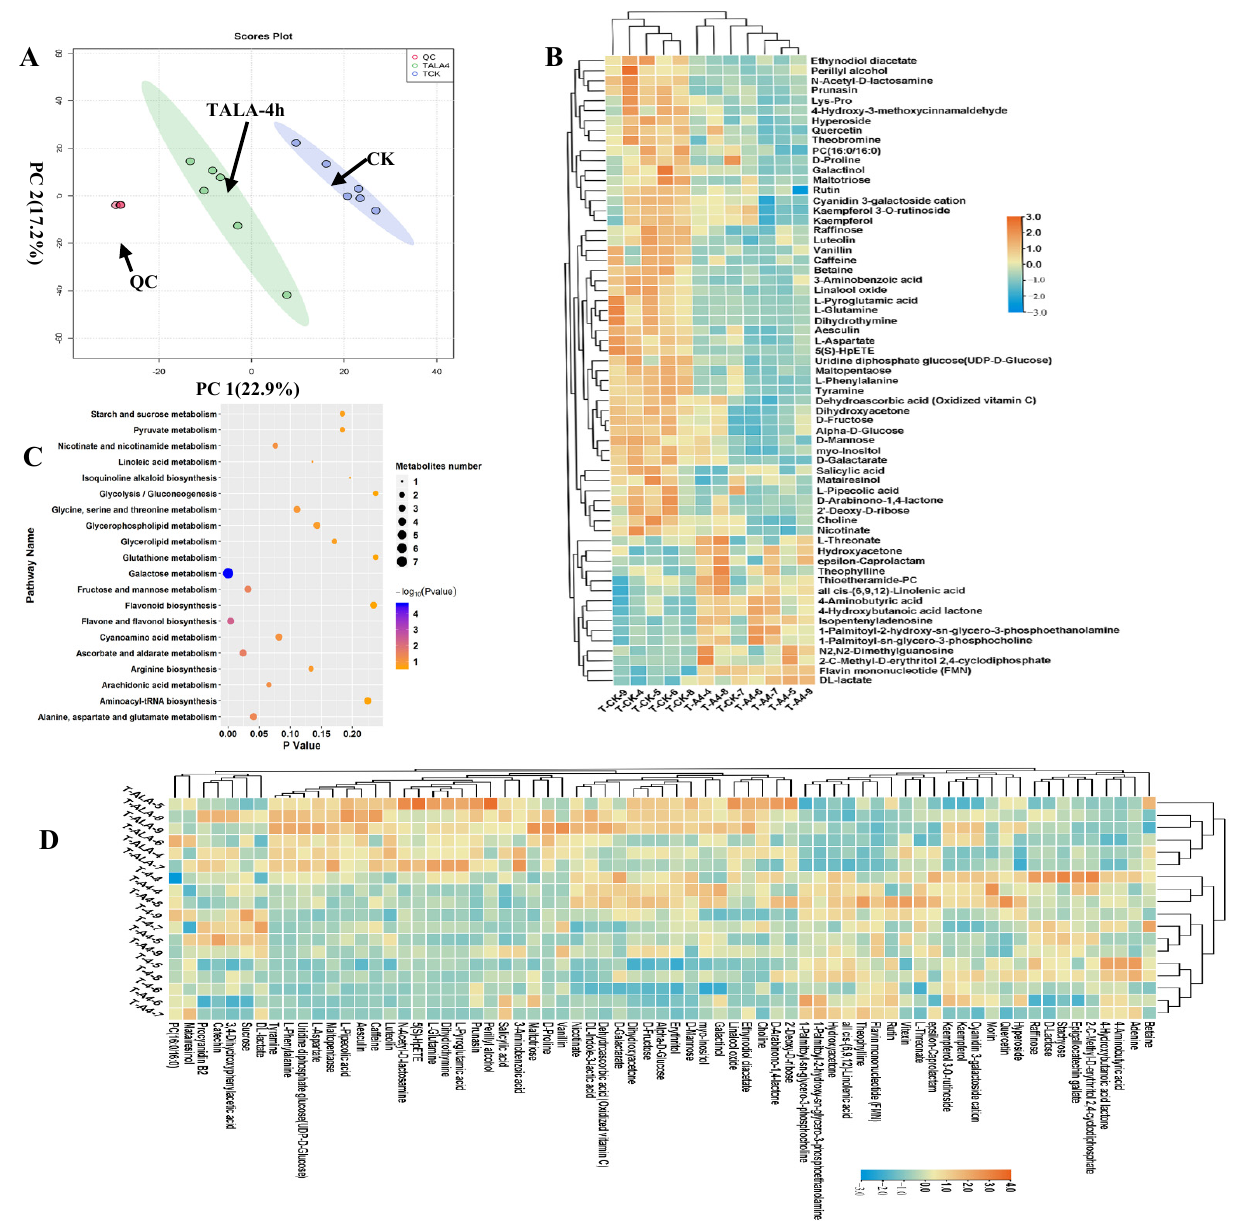
Figure 4. Metabolic alterations in ALA-treated tea tissue under cold stress. ( A ) PCA score plots for principal components 1 and 2 show high cohesion within groups and good separation among TALA-4h and CK groups. The sampling groups are color-coded as follows: green = TALA-4h; blue = CK; red = QC. ( B ) Heatmap visualization of relative levels of differential metabolites in the TALA-4h vs. CK comparison. The normalized value of peak areas of metabolites was used to represent the relative metabolite content and complete linkage hierarchical clustering. Each sample is visualized in a single column and each metabolite is represented by a single row. The up- and downregulated metabolites are shown in red and blue, respectively. ( C ) Enrichment of the differential metabolites from the TALA-4h vs. CK comparison with respect to distinct KEGG pathways. Differential metabolites were mapped to distinct metabolic pathways. Enrichment p -values were computed from a hypergeometric distribution. A p -value cutoff of 0.05 was selected as the threshold. The plot sizes represent the number of metabolites in each pathway term. ( D ) Relative levels of cold-related metabolites in ALA-treated tissues after cold stress challenge. The scale represents the normalized peak area values for each metabolite in the samples.